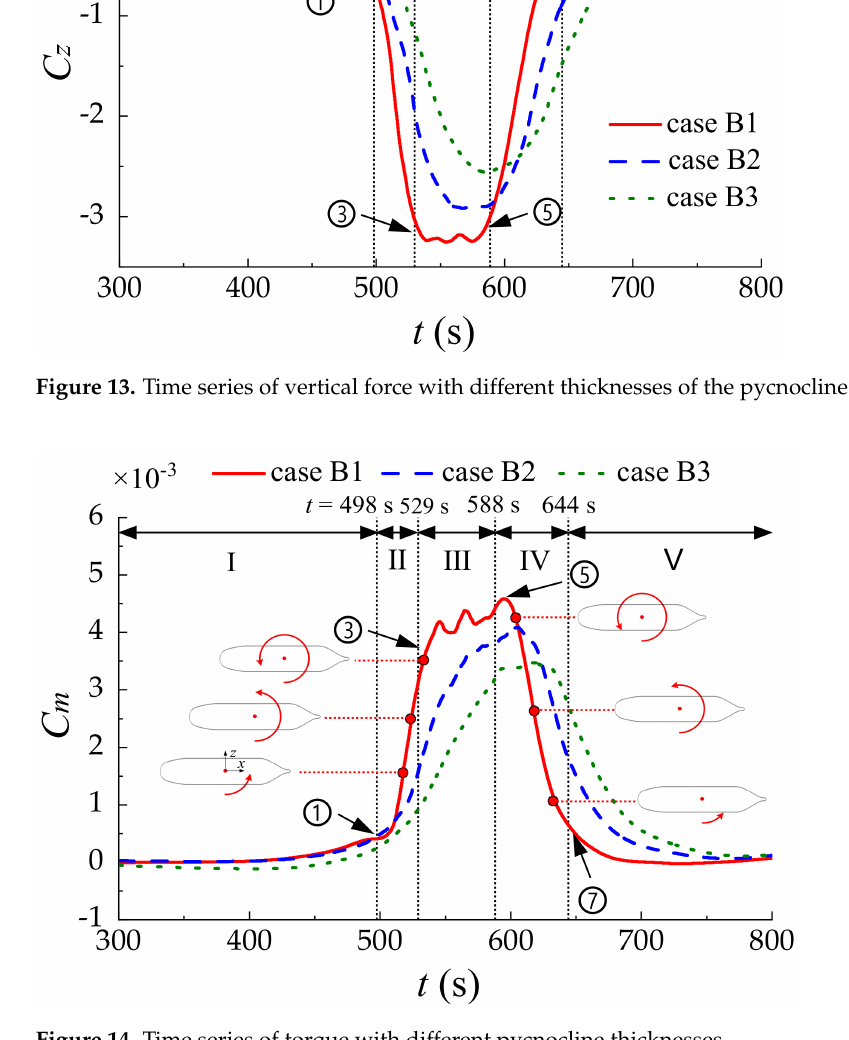
Figure 14. Time series of torque with different pycnocline